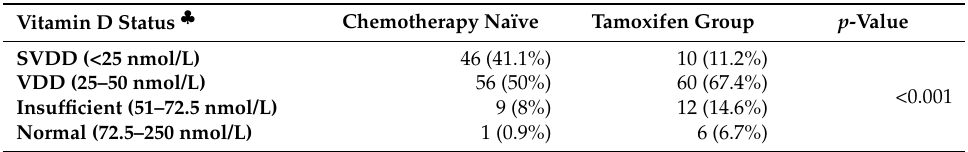
Table 4 . Vitamin D status on the basis of plasma 25(OH)D 3 concentration in chemotherapy-naïve patients and in those on tamoxifen adjuvant therapy.